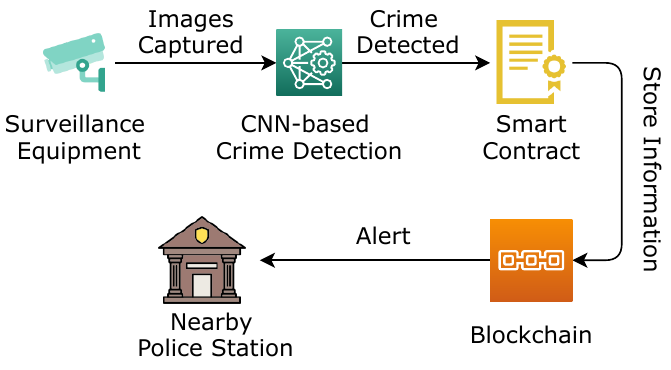
Figure 2. BlockCrime system